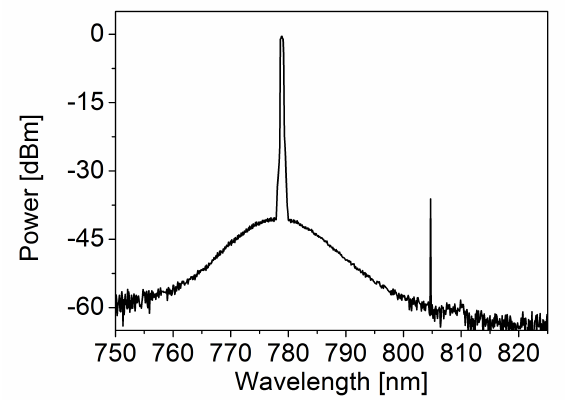
Figure 8. Experimental spectra of cascaded Raman lasing in a microsphere of 50 µ m diameter. The laser pump is centered at about 778 nm, the Raman line is centered at about 807